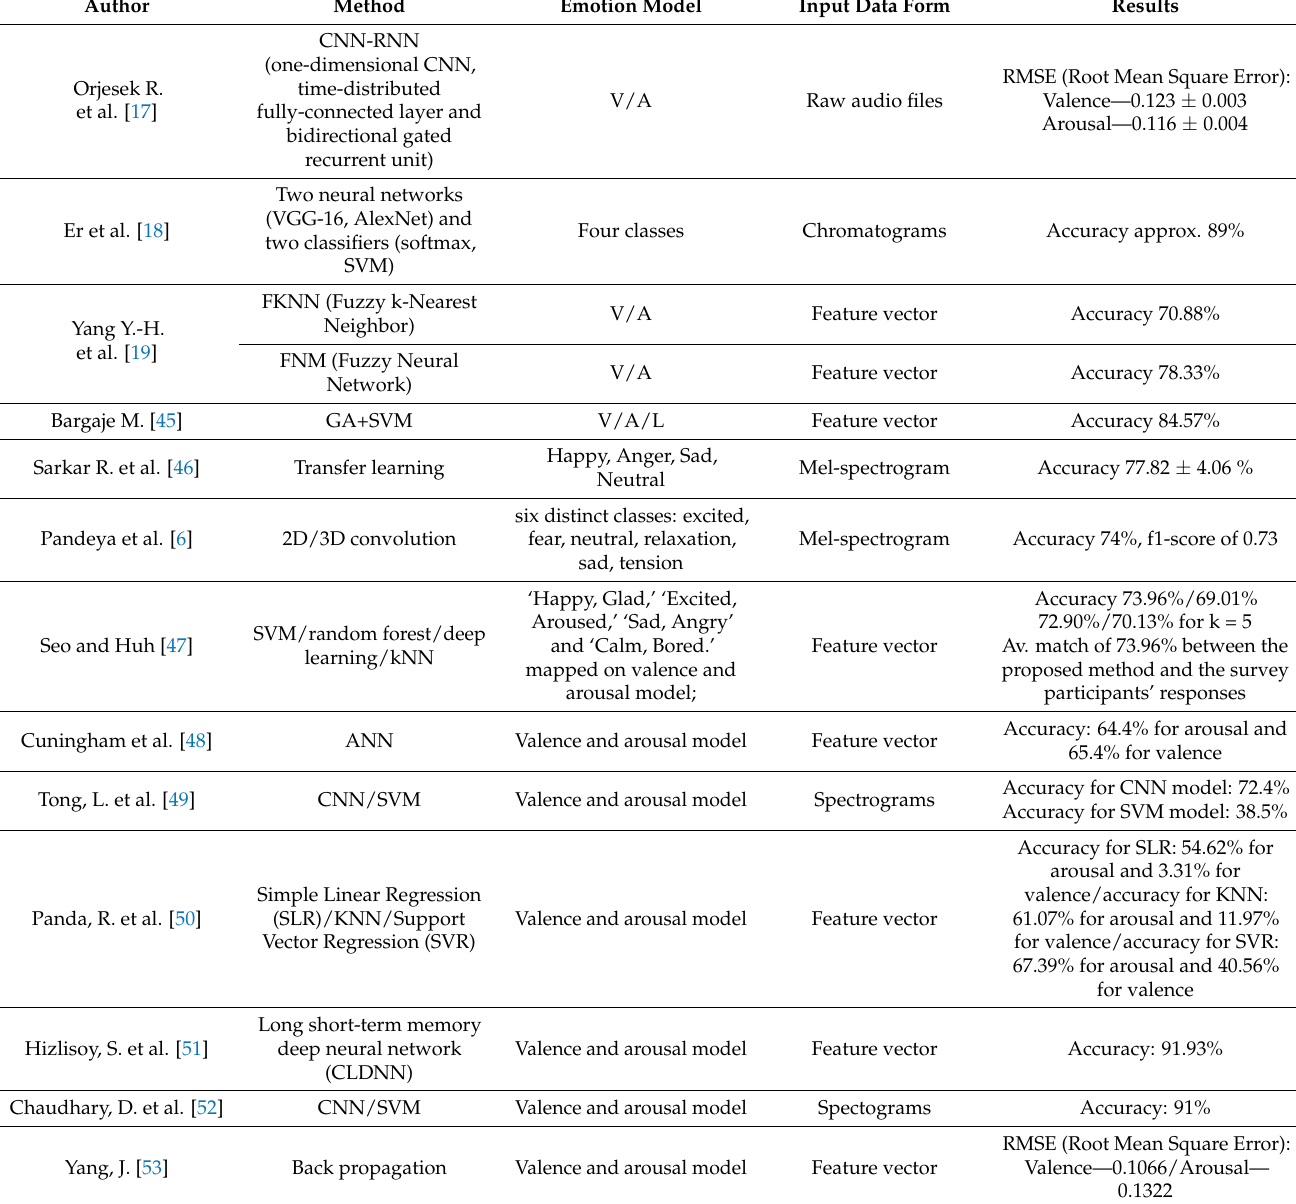
Table 1. Examples of studies with regard to emotion/mood representation and their automatic